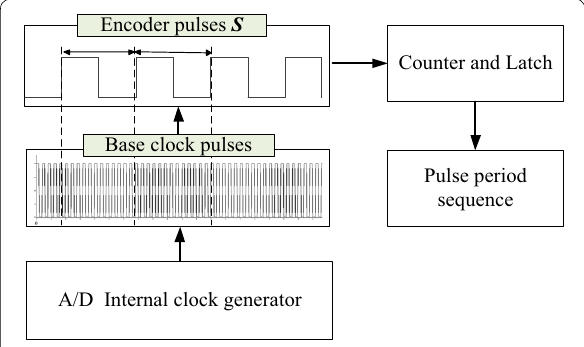
Figure 2 Measurement principle of instantaneous